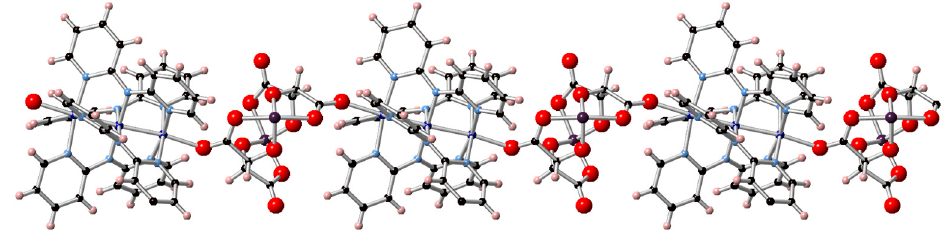
Figure 3. Representation of the coordination polymer in ∆ - 1 from X-ray diffraction data. Cobalt: dark blue, nitrogen: light blue, carbon: black, arsenic: purple, oxygen: red, hydrogen: pink.